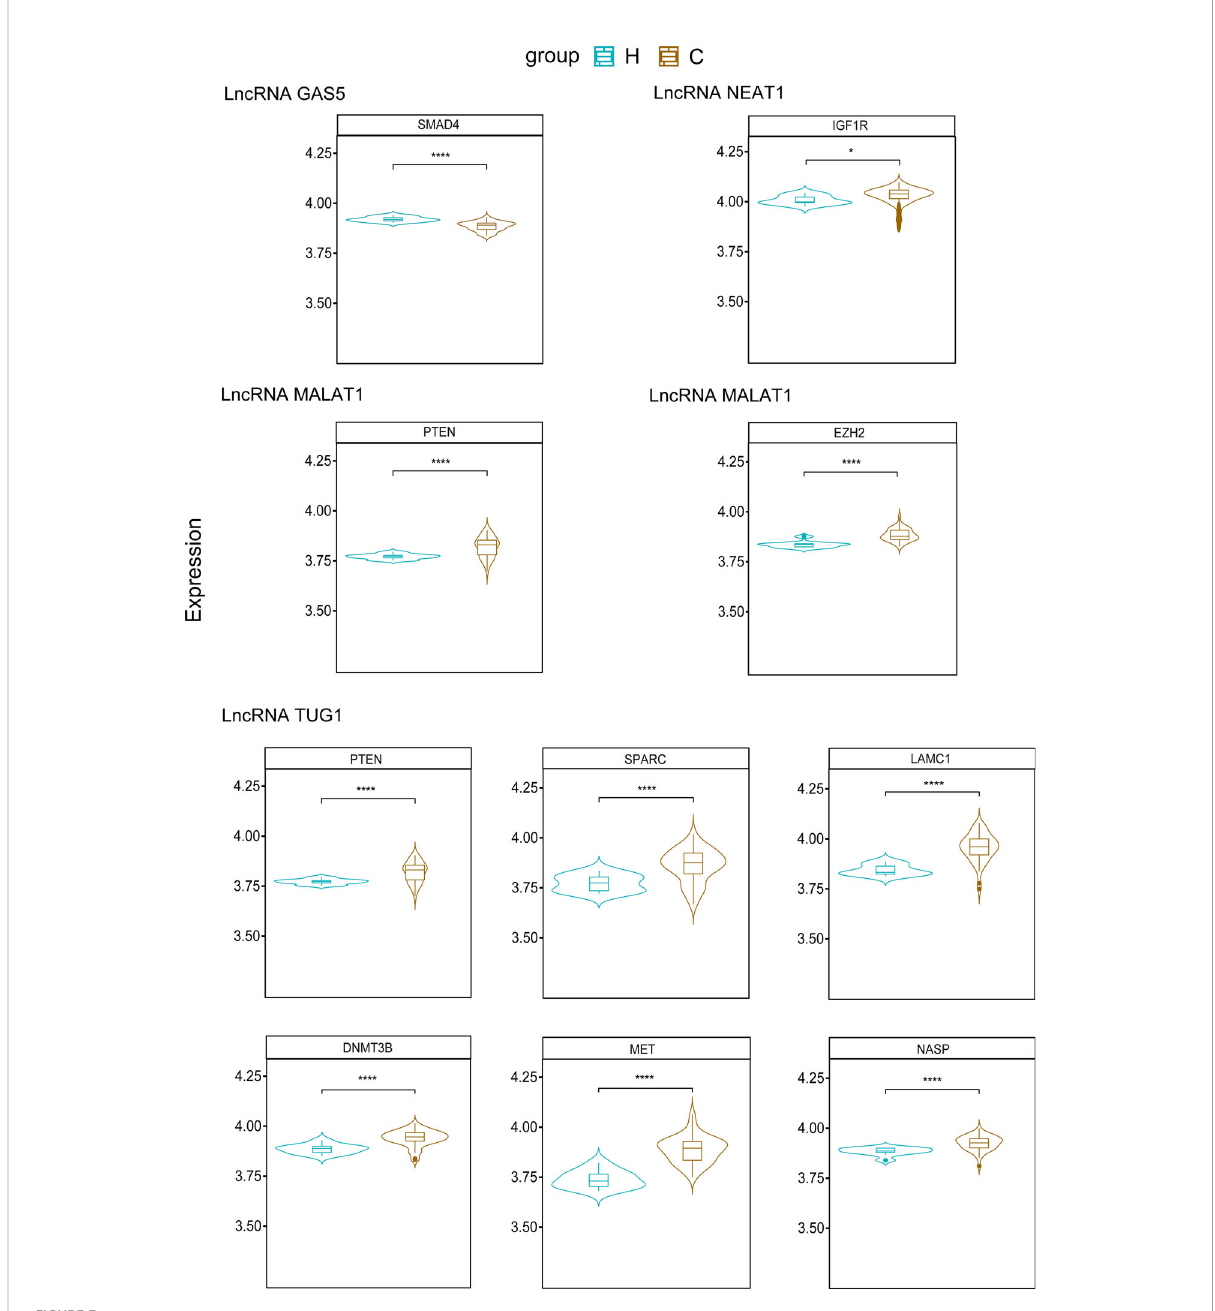
FIGURE 3 Predicted mRNAs expression of SMAD4, IGF1R, PTEN, EZH2, SPARC, LAMC1, DNMT3B, MET, NASP. (H, Health; C, COVID-19) ****P<0.0001,